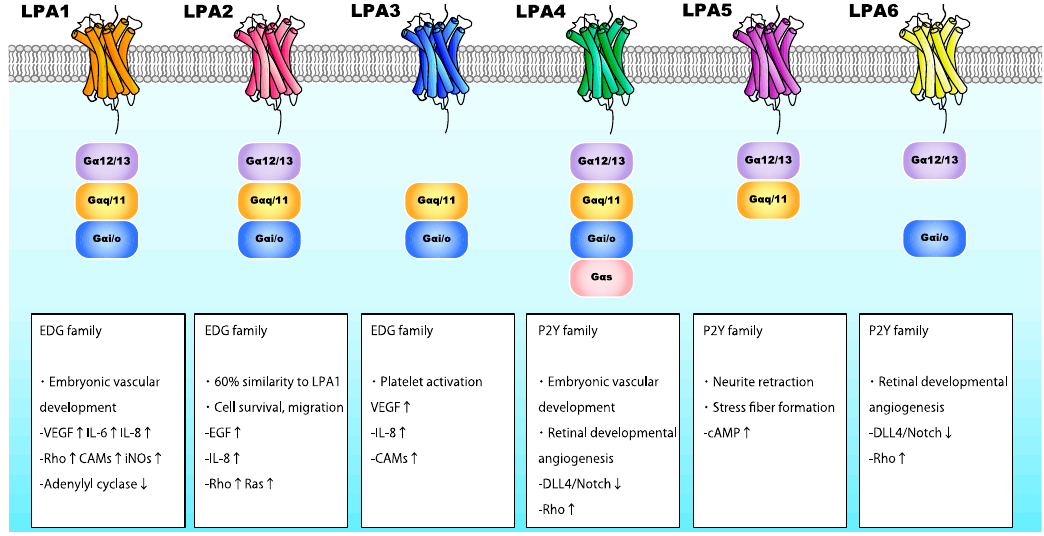
Figure 4. The role of LPA receptors in neovascularization-associated signaling pathways.